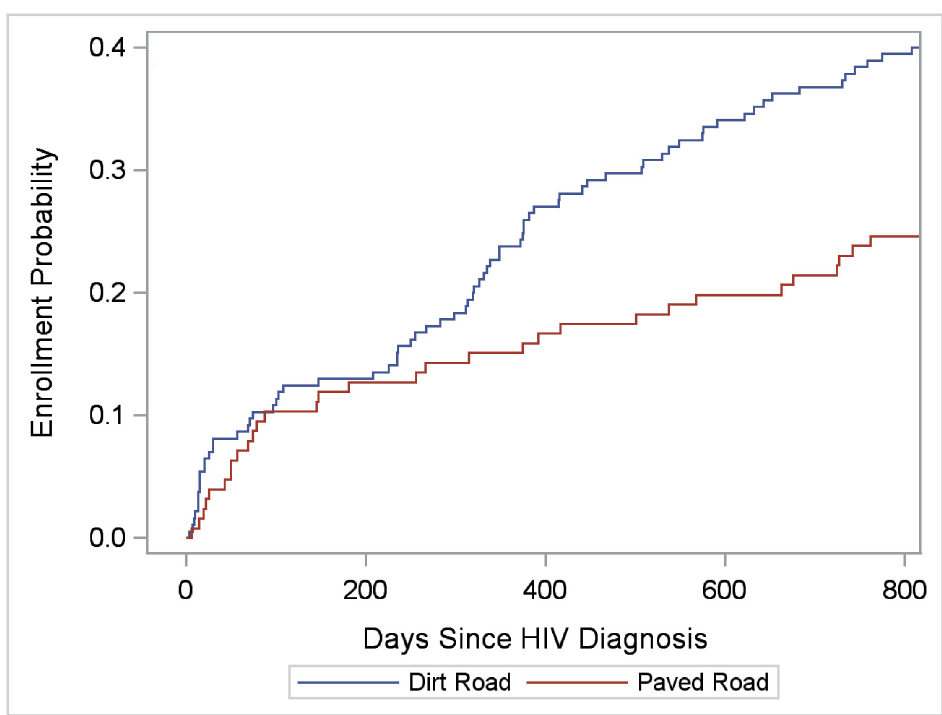
Fig 9. Cumulative verified enrollment in HIV clinics located in rural and peri-urban areas, by road condition serving the clinic, SHIMS clients only. Log-rank test for differences in functions = 8.01; P = 0.005.